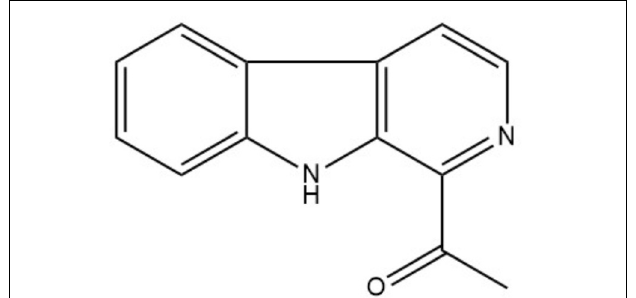
FIGURE 3 | Structure of